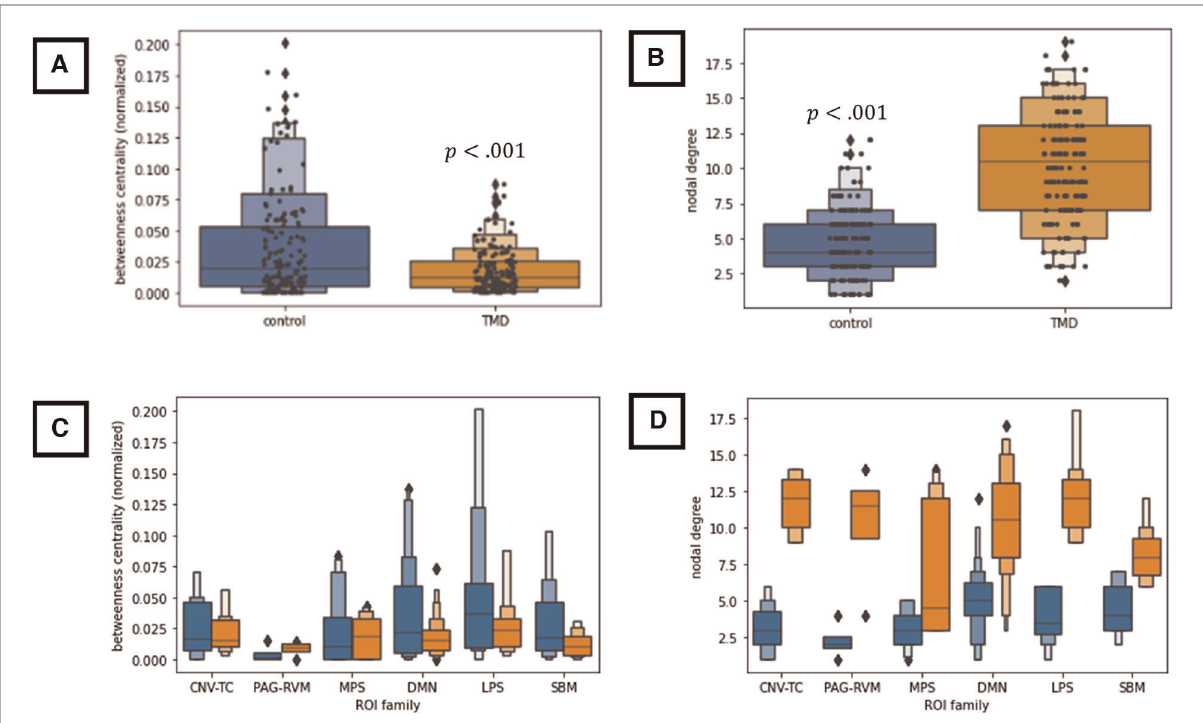
FIGURE 6 ( A,B ) Group-wise differences in node betweenness centrality ( A ) and nodal degree ( B ) across all nodes and both conditions. ( C,D ) Group-wise differences in betweenness centrality ( C ) and nodal degree ( D ) as a function of ROI family across both conditions. All results in this fi gure were computed using a linear mixed-effects model (see text), which is robust to violations of data normality. CNV-TC, trigemino-thalamocortical pathway; DMN, default-mode network; LPS, lateral pain system; MPS, medial pain system; PAG-RVM, periaqueductal grey-rostral ventral medulla pathway; SBM, derived from surface-based morphometry analyses. ROI membership in the various pain systems is de fi ned in Supplementary Table S1 . ROIs not assigned to the above pain systems ( “ not otherwise speci fi ed ” or “ NOS ” in Supplementary Table S1 ) were not included in these